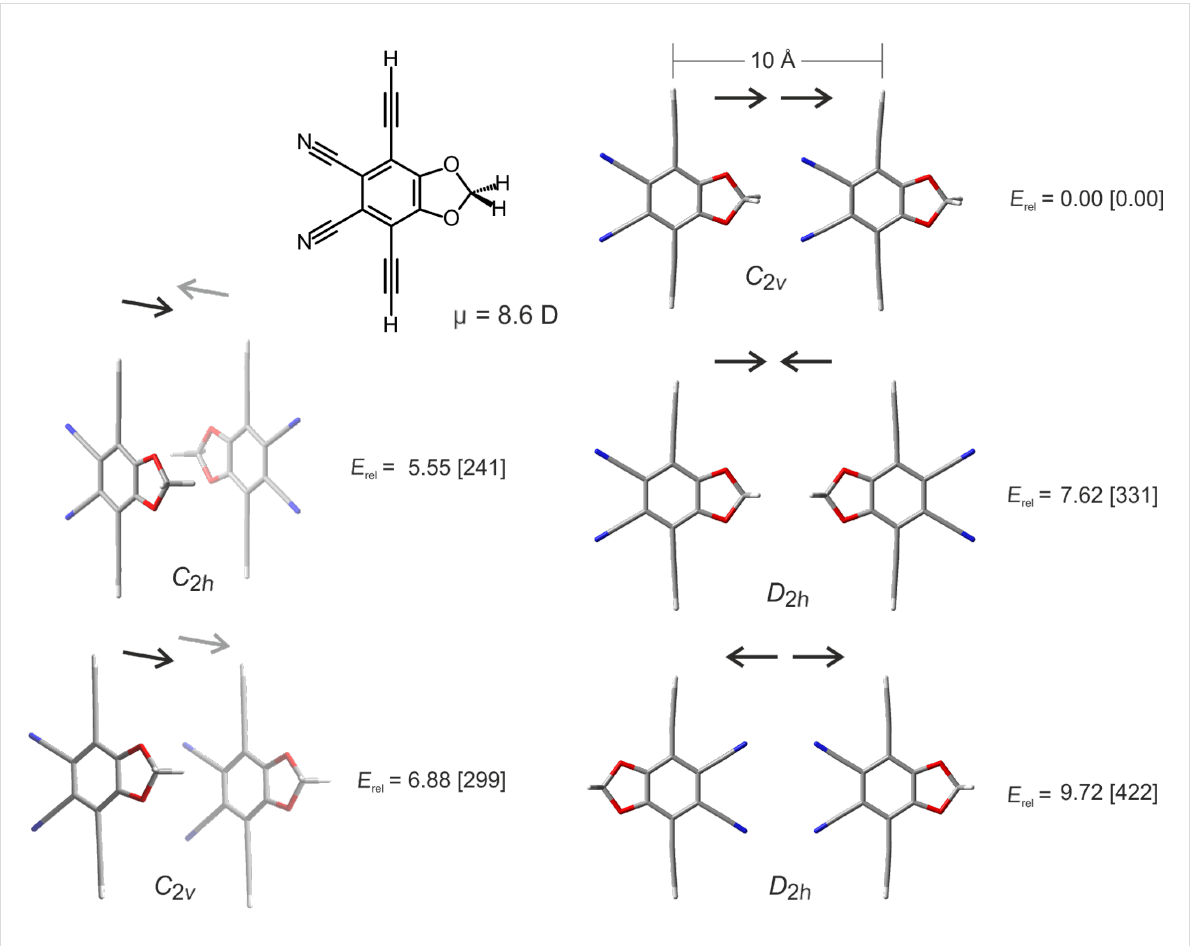
Figure 1: Interactions of a pair of dipolar rotors in different orientations. The axes of the rotors are parallel at a distance of 10 Å (terminal H atoms at the ethynyl units are in a plane and at an intermolecular distance of 10 Å), which is a typical distance in MOF lattices. The structures are fully opti- mized at the PBE-D3/defSVP level of theory within the point groups C 2 v , C 2 h and D 2 h . Relative energies ( E rel ) are given in kcal mol − 1 and in meV (in brackets). The arrows indicate the orientation of the dipoles. The calculated dipole moment µ of the rotor (chemical structure on top left) is 8.6 D.